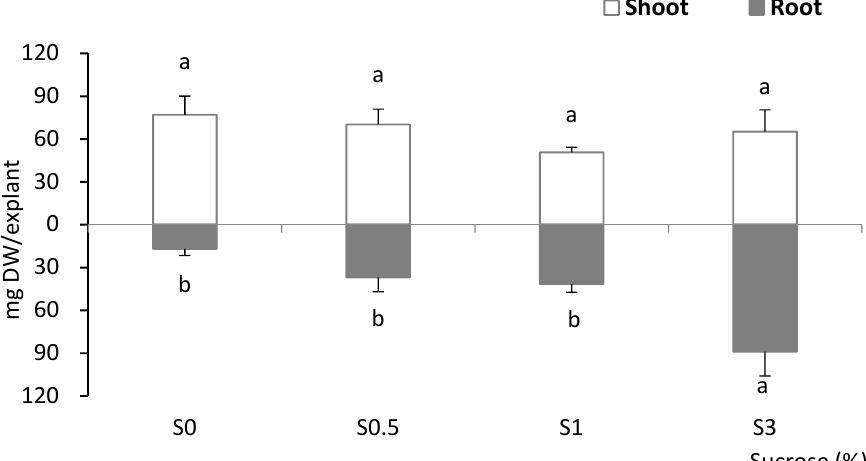
Figure 4. Effect of sucrose supplementation on shoot and root dry weight of apical sections of